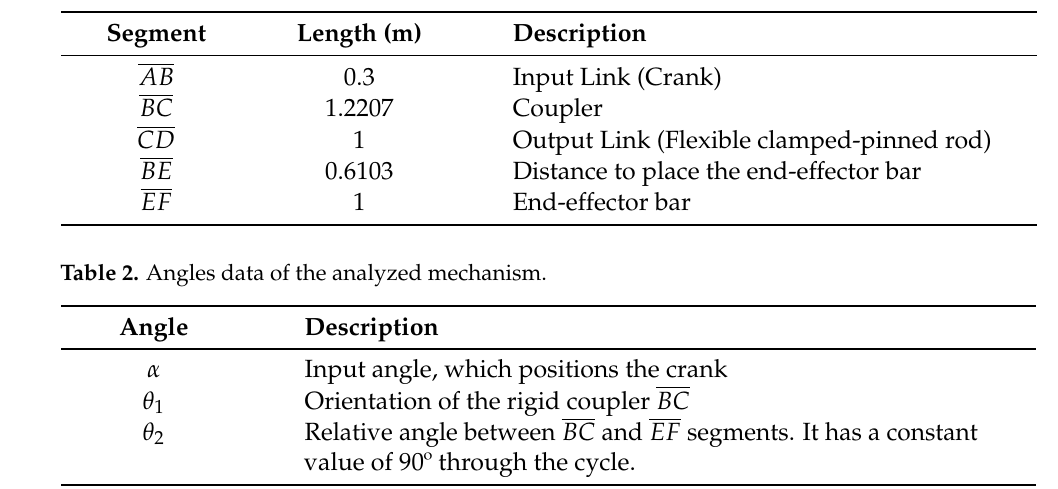
Table 1. Dimensional data of the analyzed mechanism.